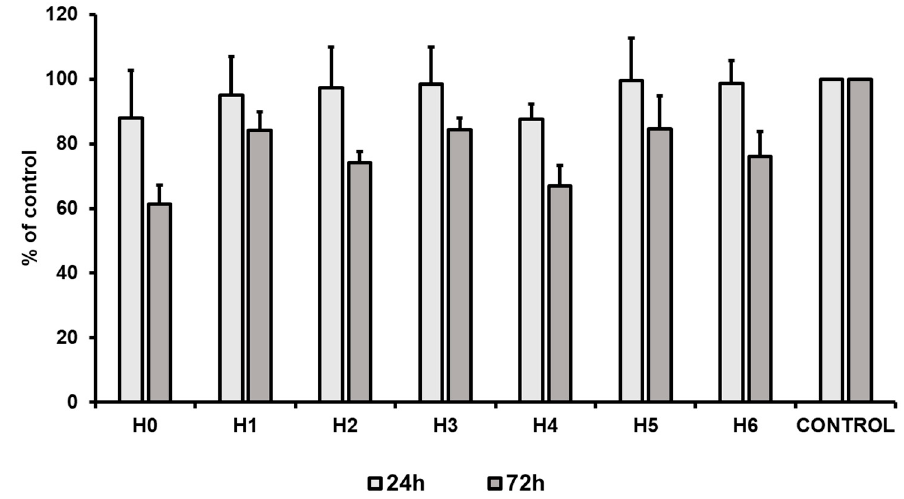
Figure 15. Proliferation of hUC-MSCs (human umbilical cord Wharton’s jelly mesenchymal stem cells) after 24 and 72 h of the cell culture in liquid extracts of chitosan-based samples (H0: chitosan (CS); H1: CS/graphene oxide (GO); H2: CS/poly(ethylene glycol) grafted graphene oxide (GO-PEG); H3: CS/reduced graphene oxide (rGO); H4: CS/GO/hydroxyapatite (HAp); H5: CS/GO-PEG/HAp; H6: CS/rGO/HAp). Data are presented as mean ±